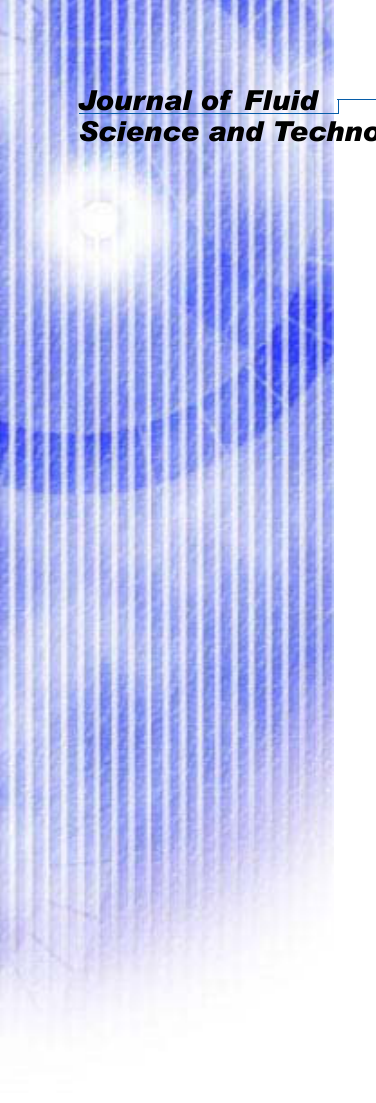
Fig.17 Power spectrum of cell concentration at point P